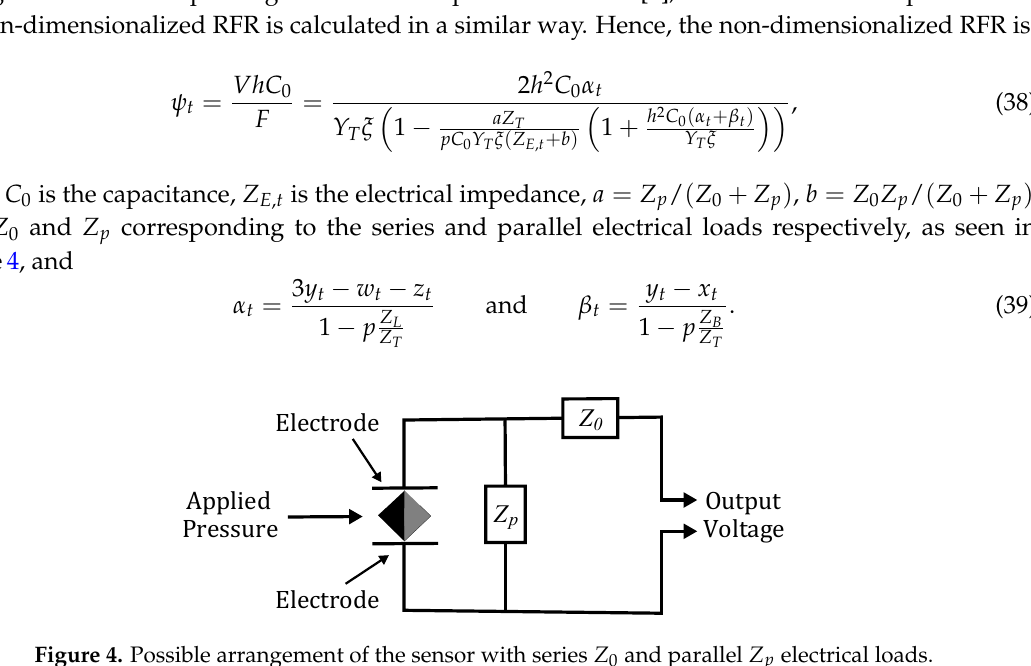
Figure 4. Possible arrangement of the sensor with series Z 0 and parallel Z p electrical